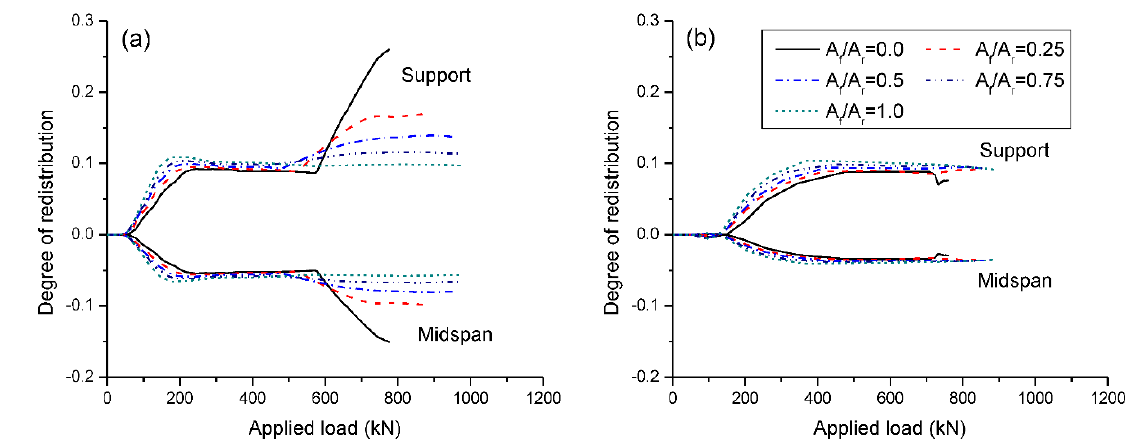
Figure 14. Load versus moment redistribution: ( a ) symmetrical loading; ( b ) unsymmetrical loading.